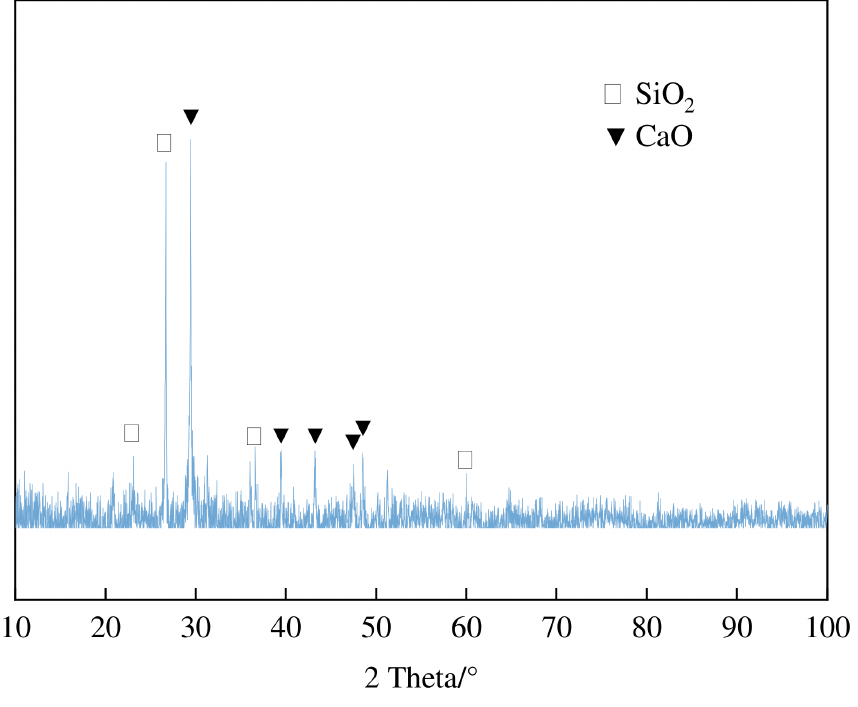
Figure 2. The XRD spectra image of the tested SS. Table 2. Main oxide of the gypsum, FA, SS and cement (unit: wt.